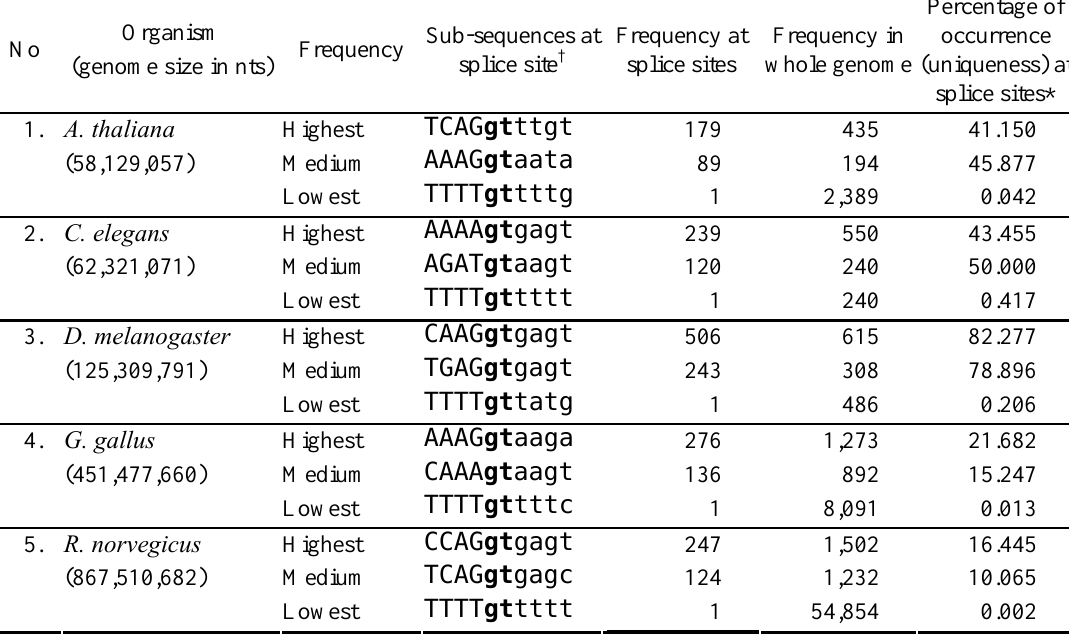
*The percentage of occurrence (uniqueness) values is normalized to three decimal points in order to represent even the lowest values. † The two central, highly conserved dinucleotides in the sub-sequences are shown in